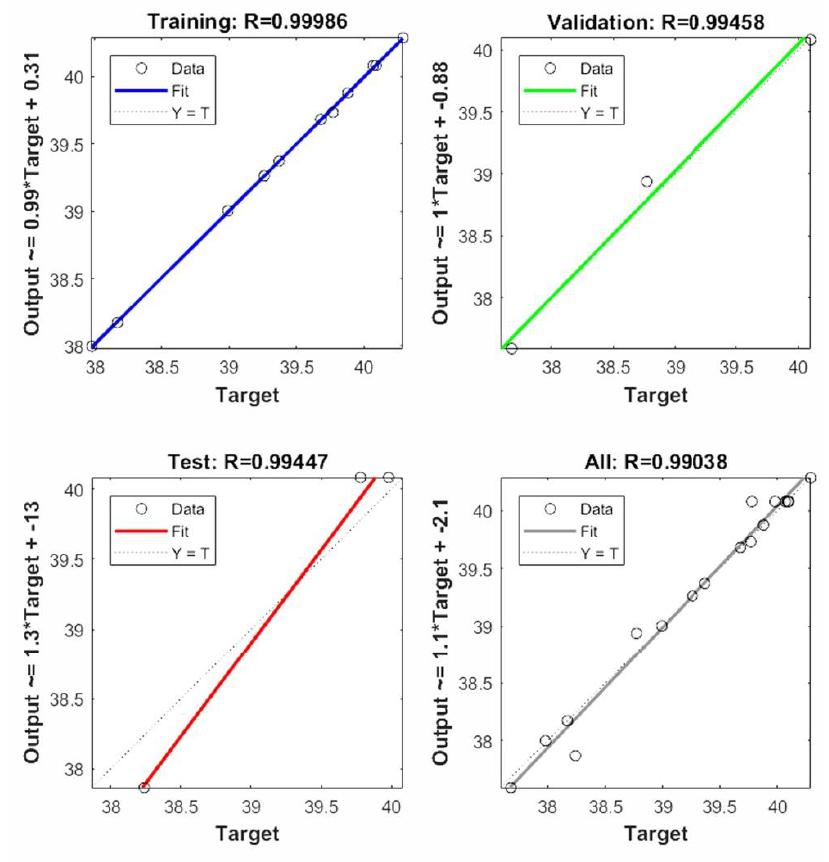
Figure 7. Neural network models with training, validation, test, and all prediction set.